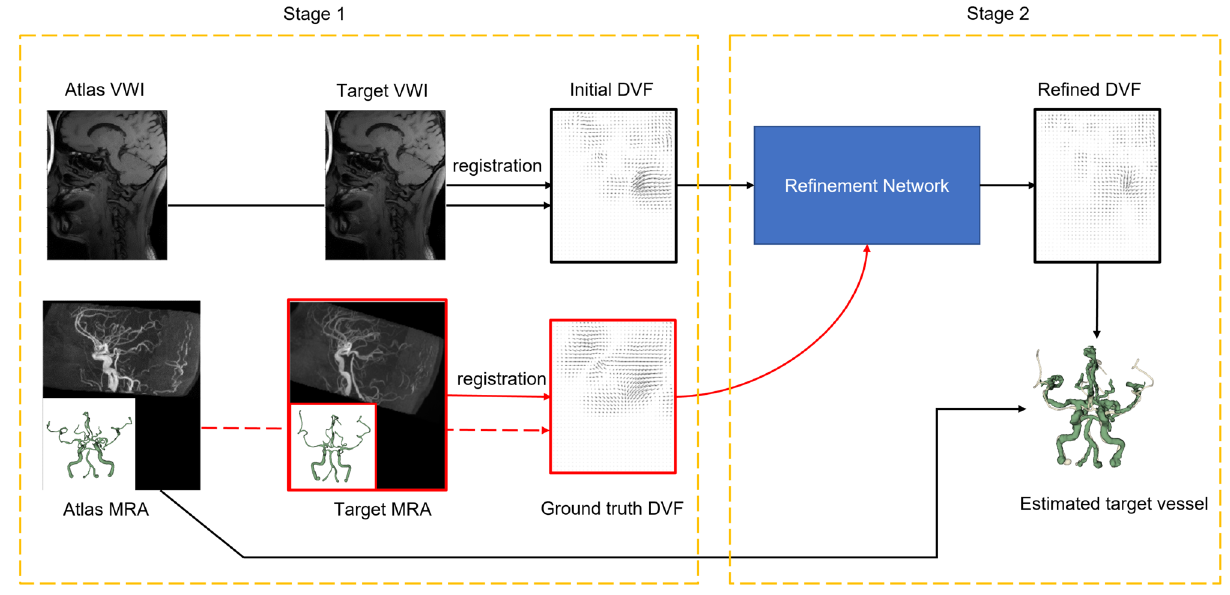
Figure 3. Design rationale. The two-stage pipeline consists of using conventional B-spline model for coarse registration and a deep-learning based refinement network for correcting registration error. Stage 1 is based on classic well-controlled registration, while stage 2 utilizes a deep network for registration refinement to map VWI-derived DVF to MRA-derived DVF. Red frames in the schema indicates modules only available and used during